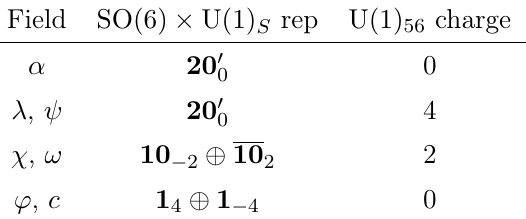
Table 3. The scalar truncation of the maximal supergravity in five dimensions relevant for the holographic dual to N = 2 interfaces with SU(2) flavor